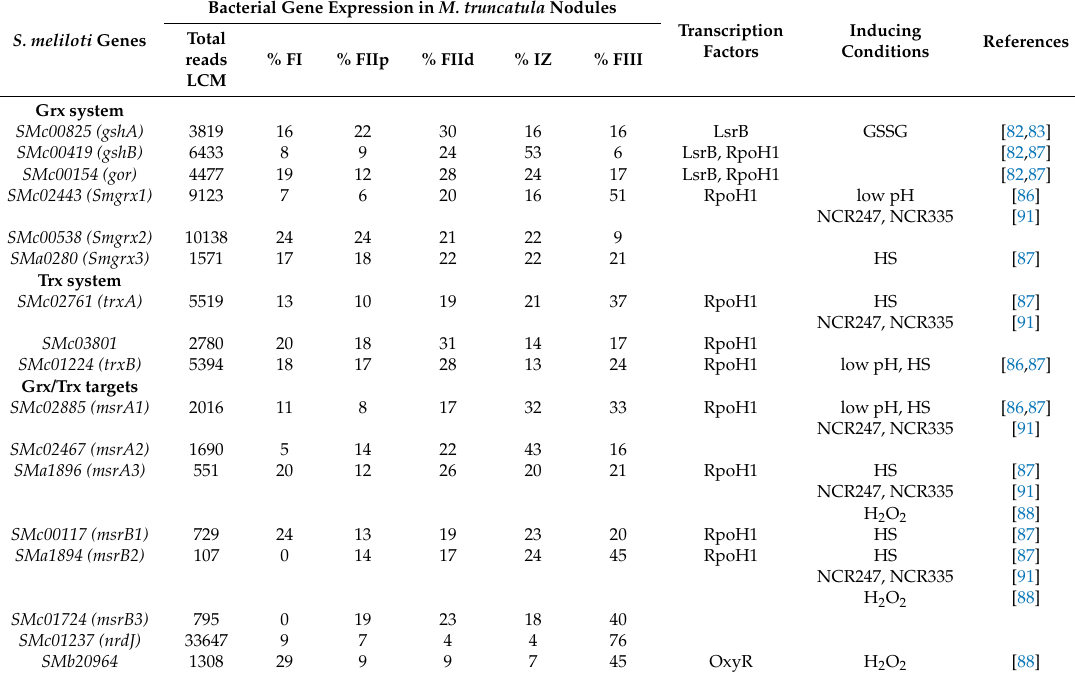
Table 3. Expression of S. meliloti genes from the Grx and Trx systems in M. truncatula nodules and regulation in free-living bacteria. Gene accession numbers are indicated in the table. Gene annotation is based on candidate orthologs and interprodomain signature. The values corresponding to gene expression in root nodules are, from left to right, total reads from laser-capture microdissection (LCM) and their distribution in each zone (%), as reported by Roux and colleagues [50]. All RNA-seq read values were normalized. The full organs were 10-day old nodules. IZ, interzone; ZIII, zone III; FI, fraction I; FIId, distal fraction II; FIIp, proximal fraction